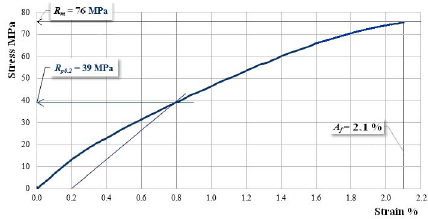
Figure 8. The characteristic curve for a sample B00.